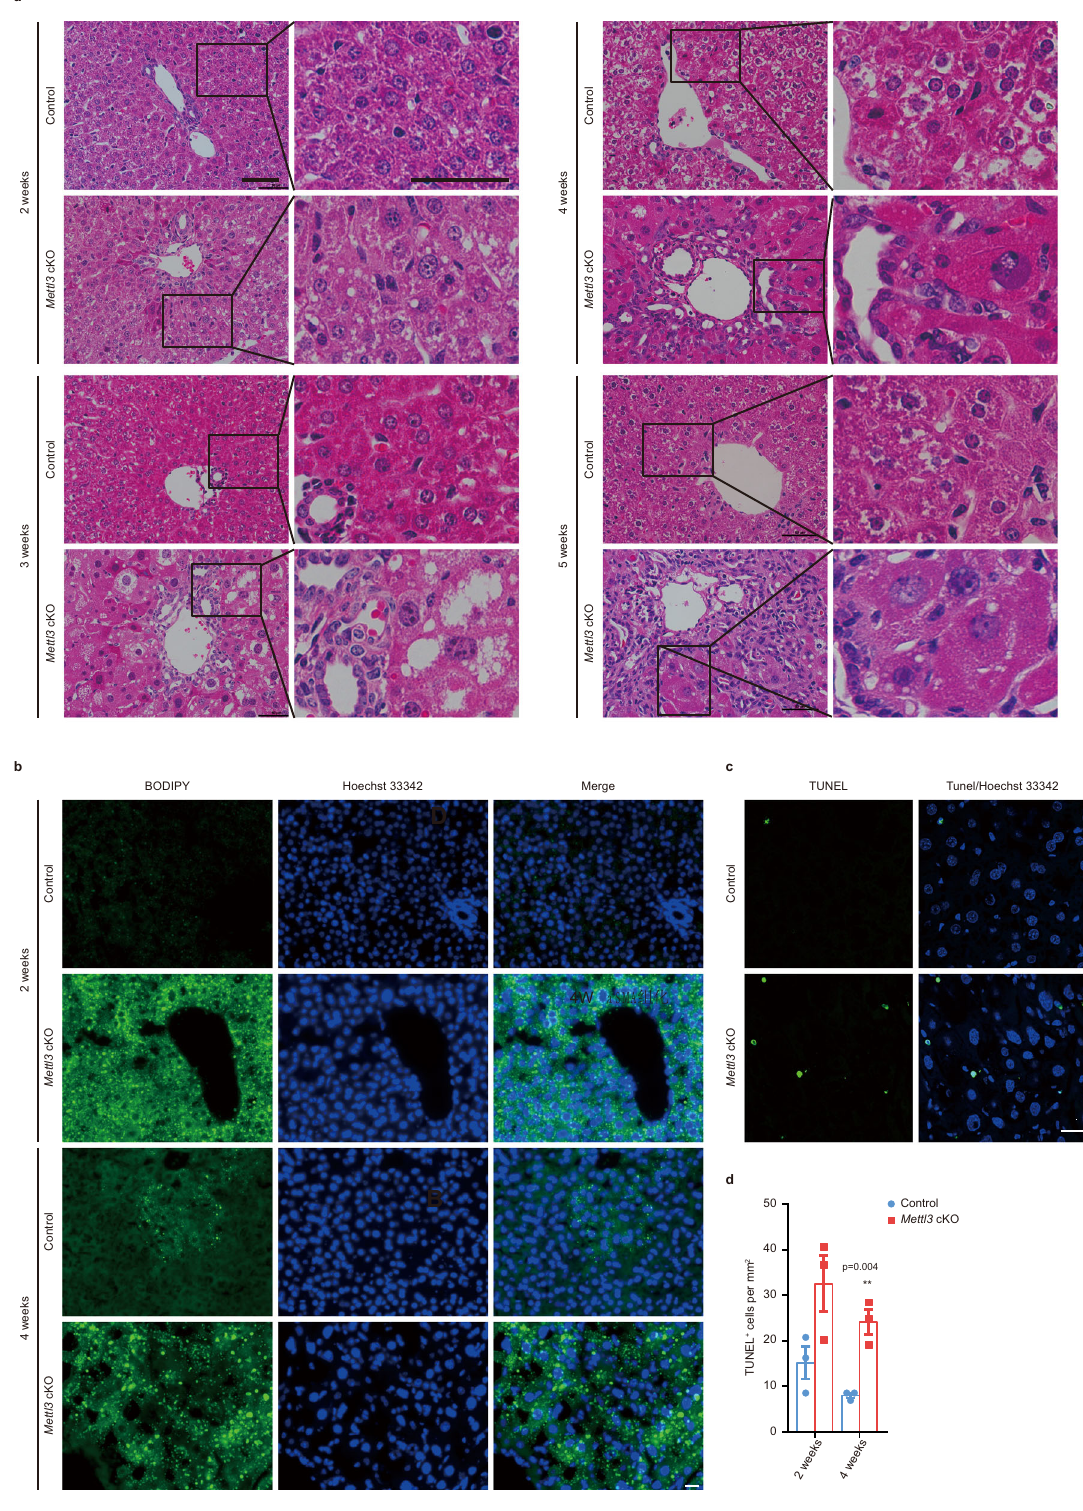
Fig. 3 | Hepatic deletion of Mettl3 in mice induces steatosis and apoptosis. a Representative H&E staining photographs of liver sections from Control and Mettl3 cKO mice at indicated time points postnatally (10 experiments were repe- ated independently with similar results). Scale bar=50 μ m. b Representative BODIPYstaining fl uorescentphotographsoffrozenliversectionsfromControland Mettl3 cKO mice at 2 weeks and 4 weeks after birth (6 experiments were repeated independently with similar results). Cell nuclei were counterstained with Hoechst 33342 (also hereafter in similar experiments). Scale bar=20 μ m. c Representative